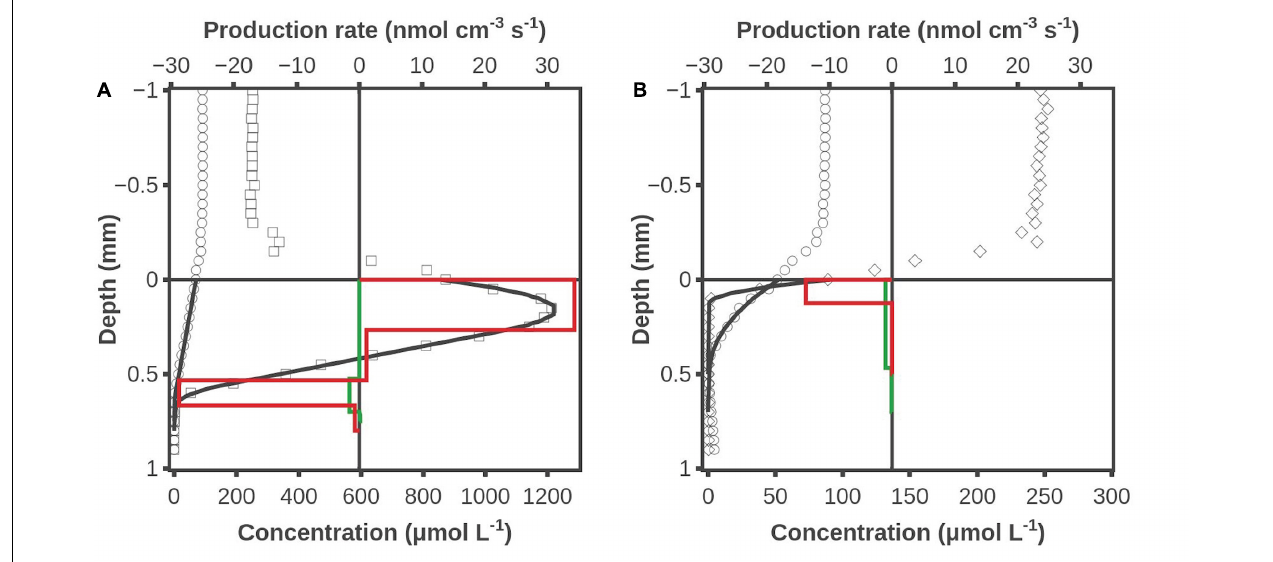
FIGURE 4 | O 2 and H 2 concentration profiles when H 2 was added to the water phase. (A) After 2 h of illumination, (B) after 2 h of dark incubation. Shown are measured H 2 concentrations ( ), O 2 concentrations during illumination ( (cid:3) ), O 2 concentration during darkness ( (cid:5) ), modeled H 2 and O 2 concentrations ( –––– ), modeled H (cid:35)